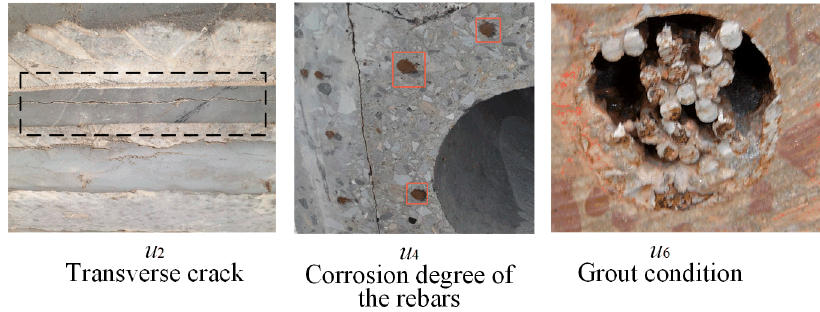
Figure 6. Diagram of indicators u 2 , u 4 , and u 6. Table 2. Classi fi cation of bridge condition state.